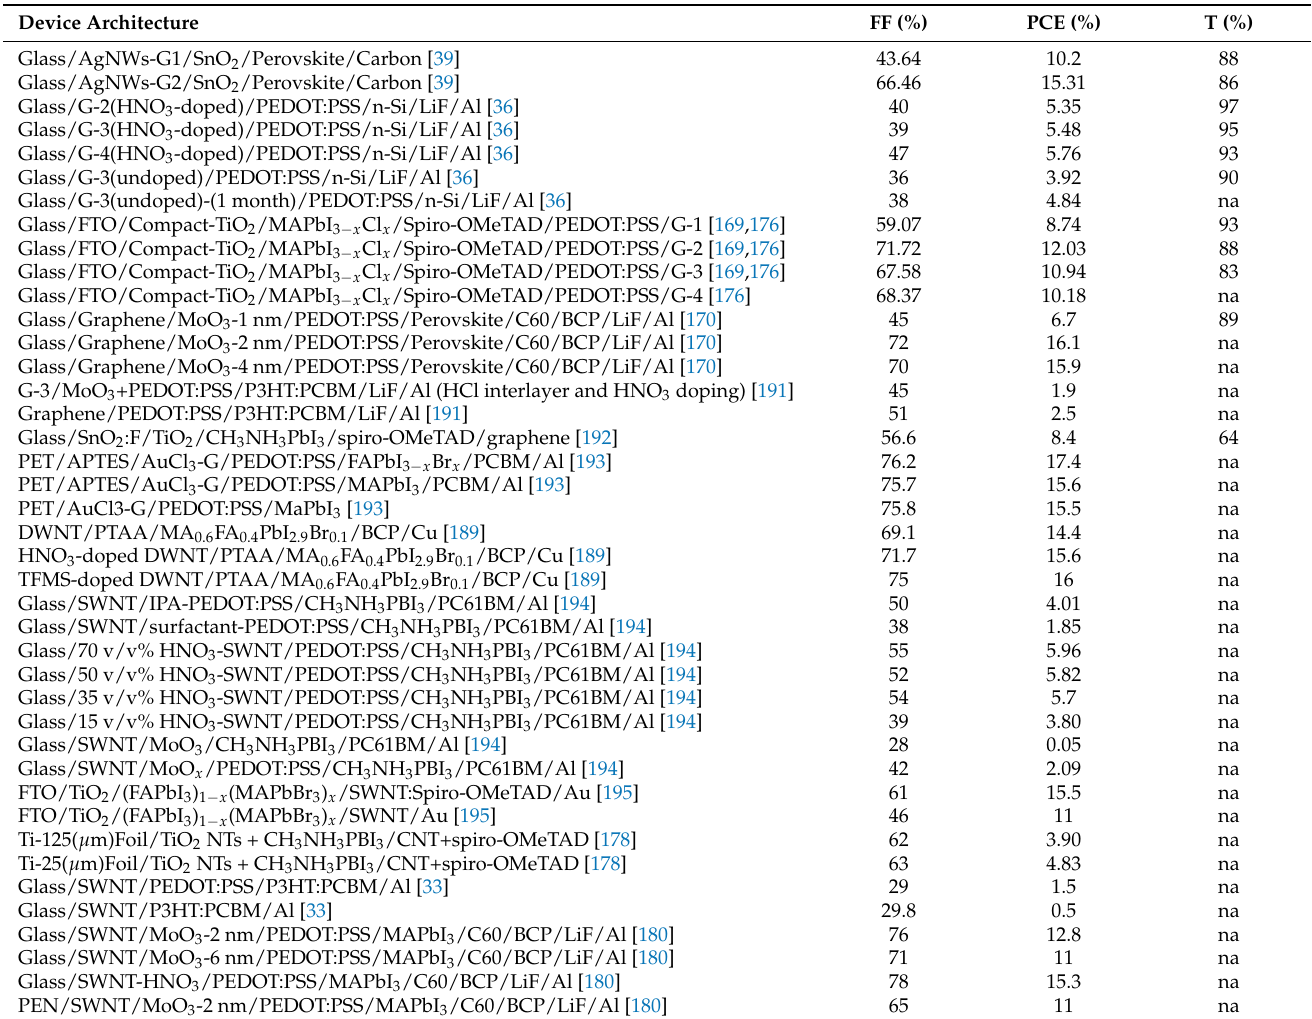
Table 3. Literature summary of carbon-material based transparent electrodes used in solar